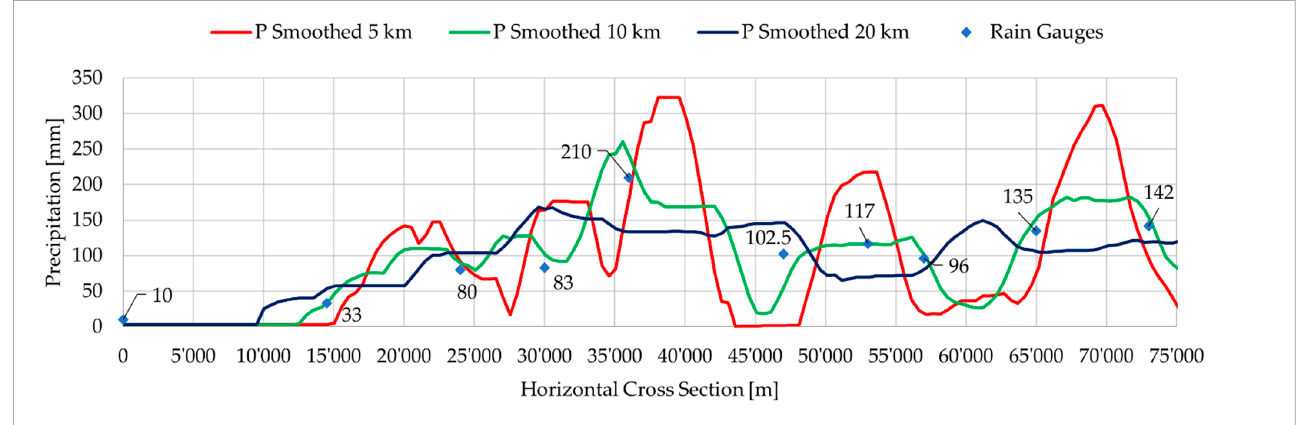
Table 6. Rain gauge comparison with model precipitation field and errors assessment.